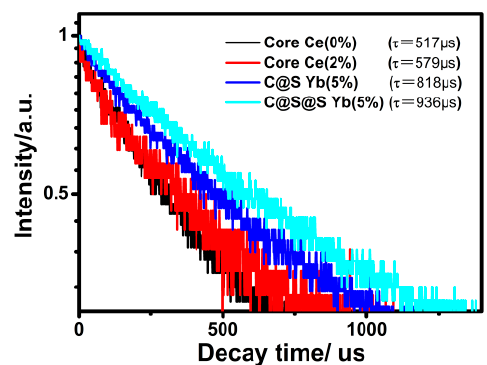
Figure 7. The lifetime of the 4 I 13/2 level of Er 3+ (monitored at 1530 nm corresponding to the 4 I 13/2 → 4 I 13/2 ) in BaLuF 5 :18%Yb 3+ , 2%Er 3+ NPs, BaLuF 5 :18%Yb 3+ ,2%Er 3+ , 2%Ce 3+ NPs, BaLuF 5 :18%Yb 3+ ,2%Er 3+ ,2%Ce 3+ @BaLuF 5 :5%Yb 3+ NPs by using a 980 nm pulsed laser with a pulse width of 100 μ s and a repetition rate of 20 Hz as the excitation source.